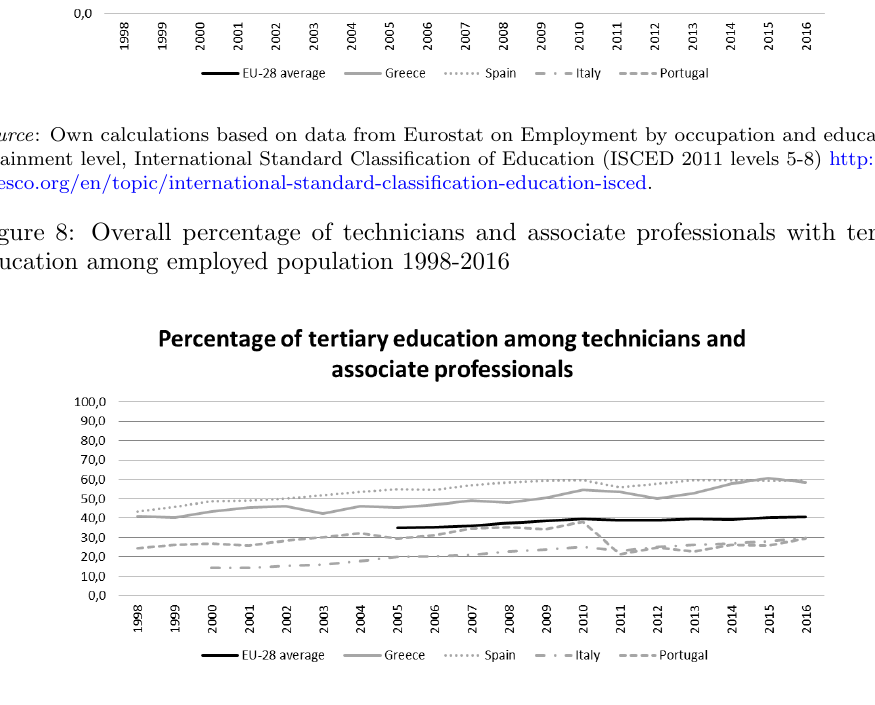
Figure 9: Percentage of technicians and associate professionals with tertiary education among technicians and associate professionals